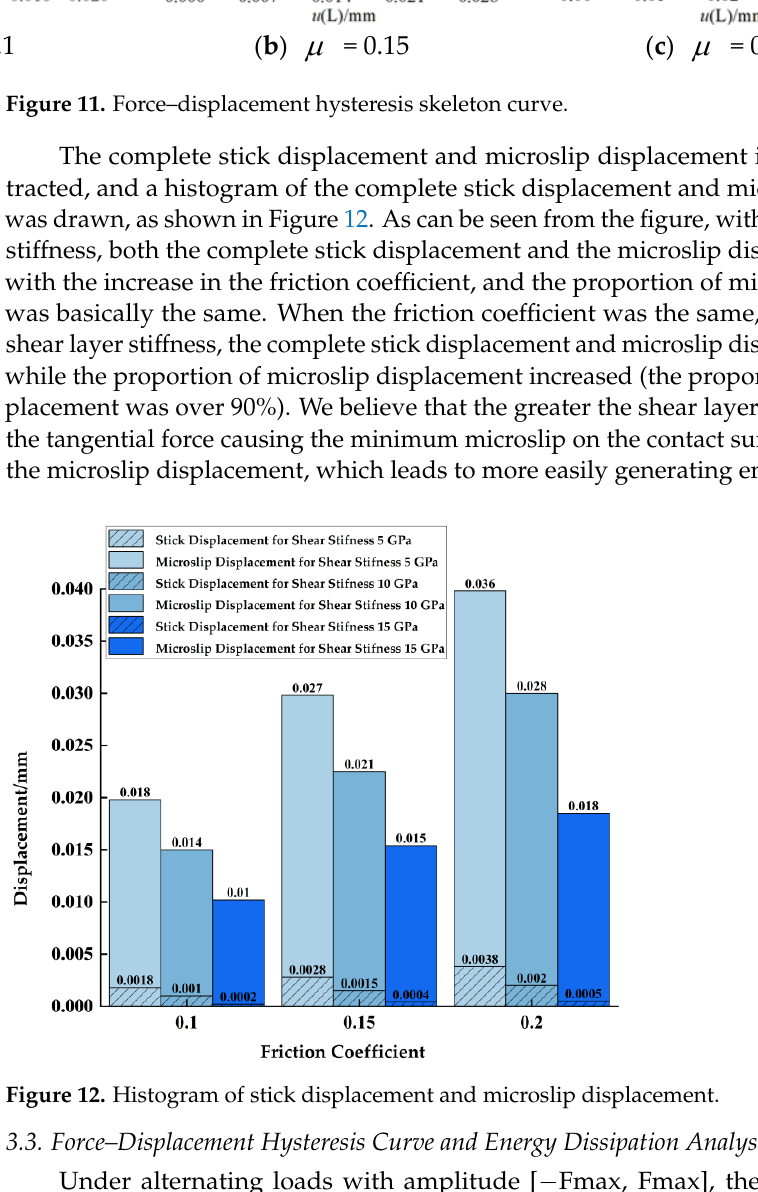
Figure 12. Histogram of stick displacement and microslip displacement.